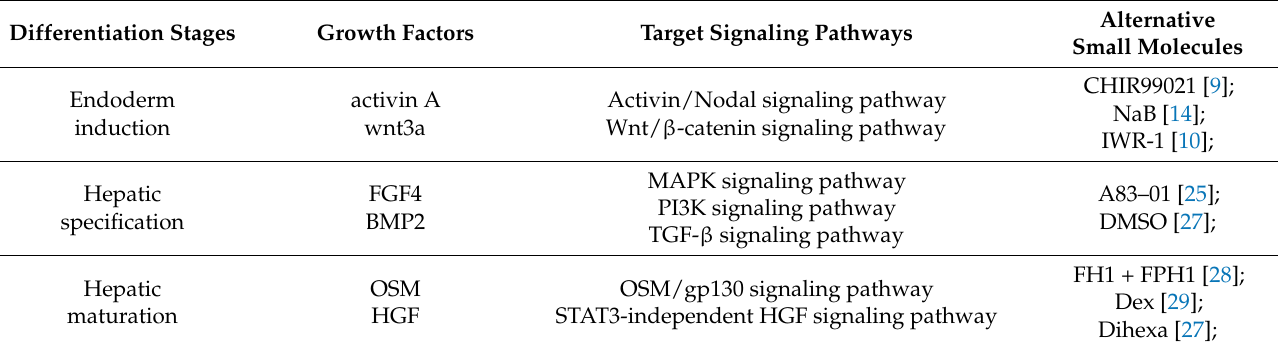
Table 1. Summary of common growth factors and alternative small molecules during the differentiation of HLCs from